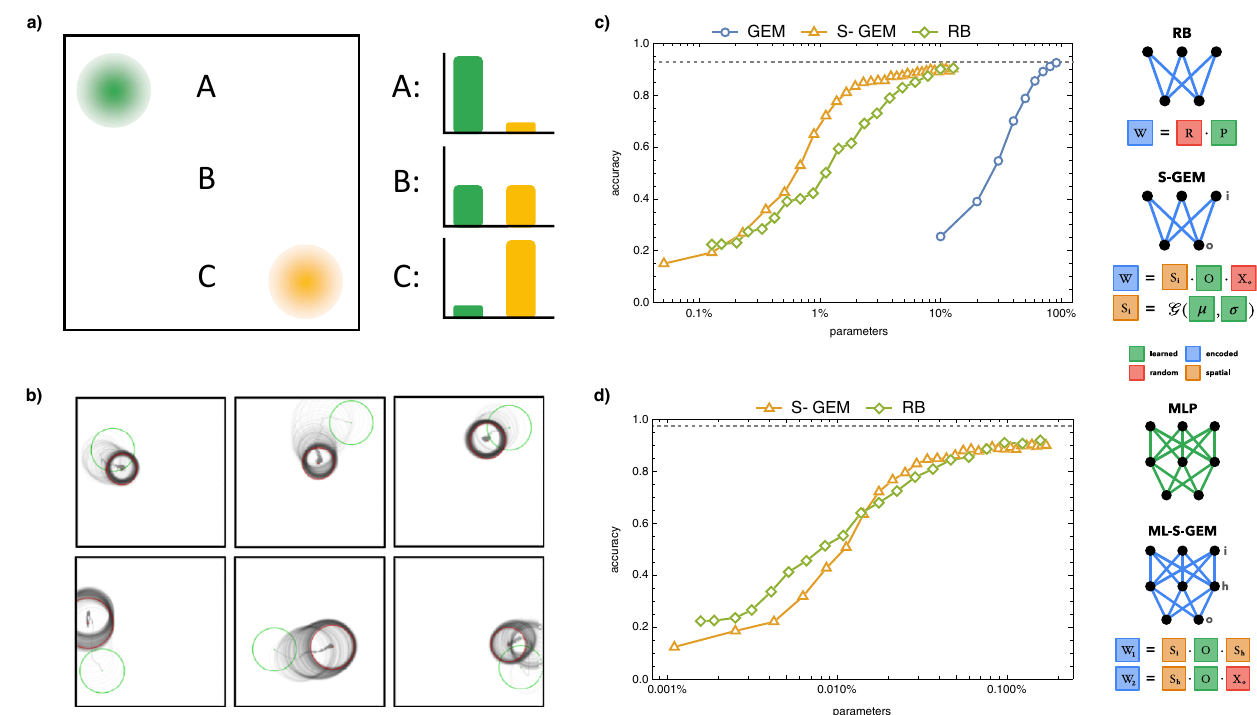
Fig.2|SpatialGEM.a InthespatialGEM,cellidentitiesaredeterminedbyneurons ’ distancefrom 2-D gene expression gaussians. Given two spatialgene distributions, green and yellow, we have: neuron A with high expression of green and low expressionofyellow,neuronBwithmediumexpressionofbothgenes,andneuron C with low expression of green but high expression of yellow. b As learning pro- gresses, the location ( µ ) and dispersion ( σ ) of the gene expression distributions change from start (green) to fi nish (red). c Left: Parameter-accuracy tradeoff for encoding a single layer linear classi fi er that solves MNIST, where parameters are